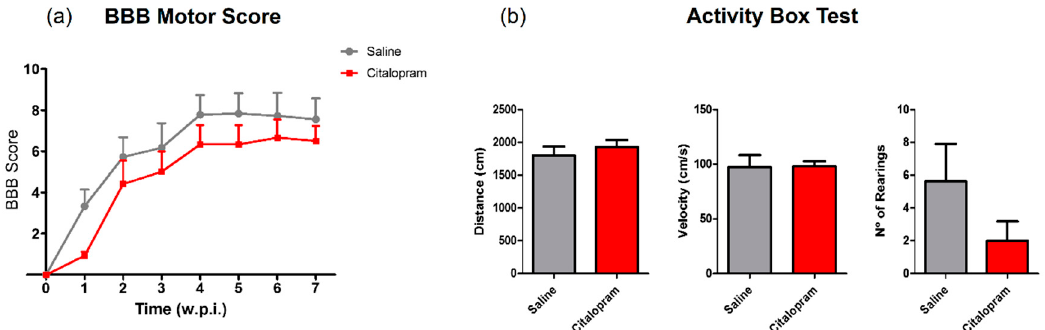
Figure 9. Impact of 8-week citalopram treatment on functional recovery. ( a ) BBB score was used to assess motor recovery 3 days after the injury and once per week thereafter until the end of the experiment; ( b ) distance traveled, velocity and the number of rearing behaviors were analyzed using the ABT test to evaluate gross motor recovery. Citalopram- n = 7 and vehicle-treated animals n = 8. Values shown as mean ± SEM. BBB—Basso, Beattie and Bresnahan; ABT— activity box